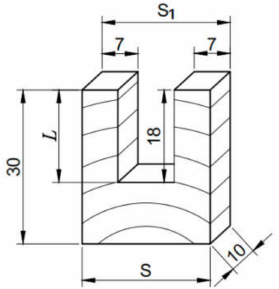
Figure 3. The prong processing and residual stress